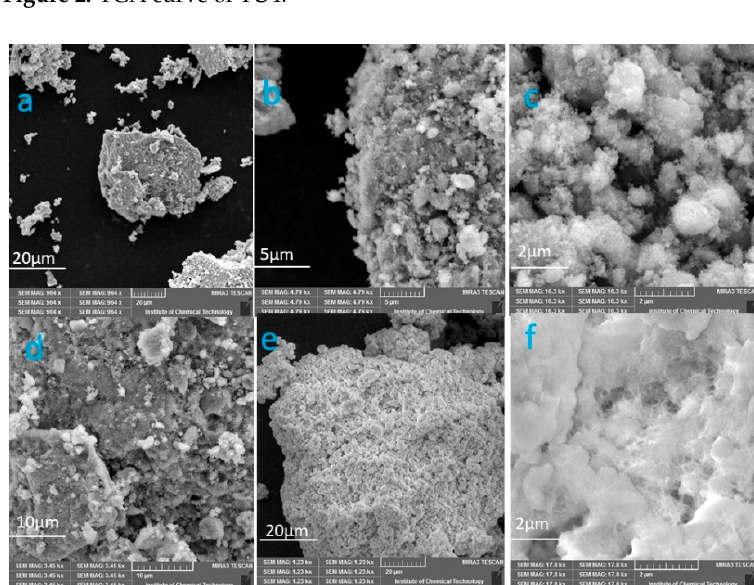
Figure 3. SEM images of ( a ) TU0,( b ) TU1, ( c ) TU2, ( d ) TU3, ( e ) TU4, ( f ) TU5.